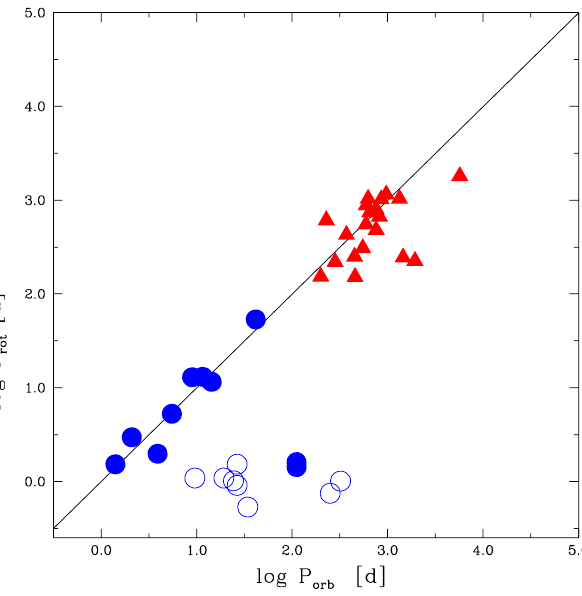
Figure 1: P rot versus P orb on a logarithmic scale. The blue circles indicates the High-mass X-ray Binaries - filled symbols for giant/supergiant systems and open symbols for Be/X-ray binaries. The red triangles indi- cates the S-type symbiotic